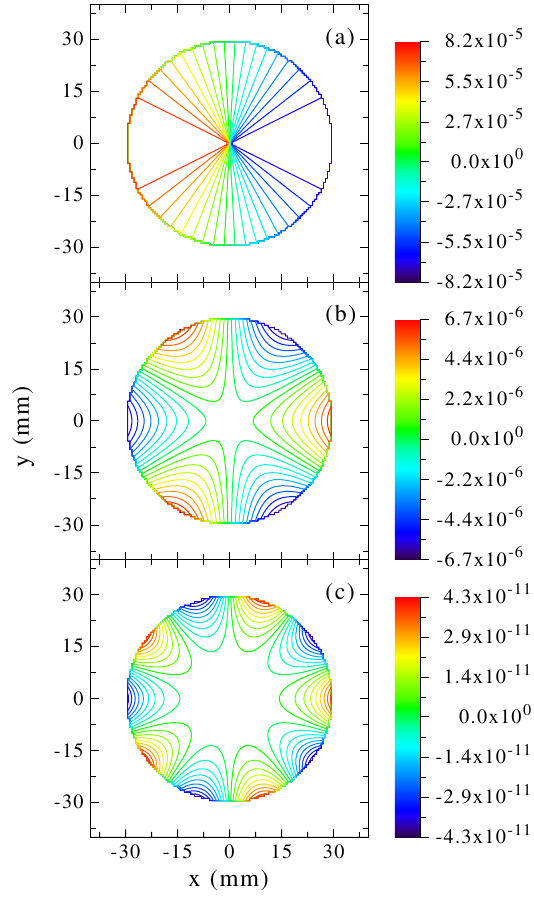
FIG. 2. Harmonic field B (cid:1) (T) profiles up to n ¼ 5 in the region of r (cid:3) R min by Eq. (5) with geometry of Fig. 1. (a) Dipole n ¼ 1 ,